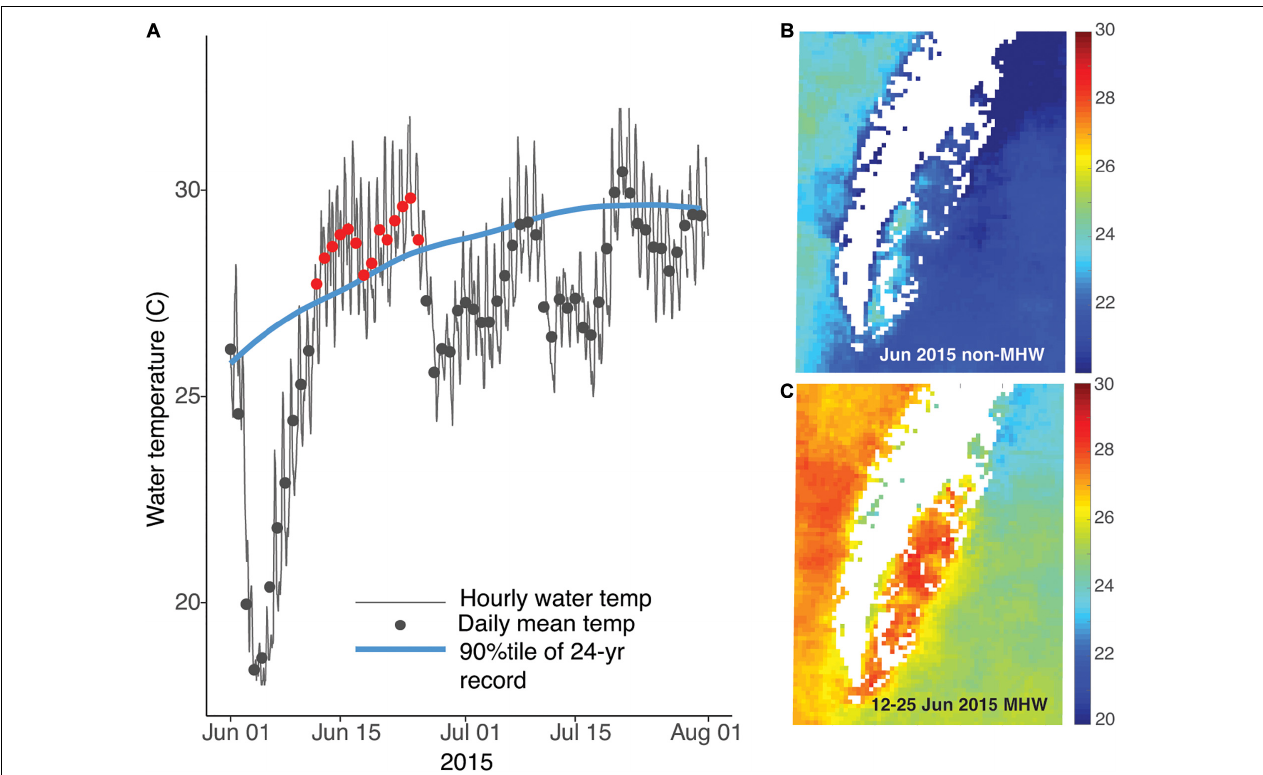
FIGURE 2 | (A) Summer 2015 water temperature at the NOAA tide station in Wachapreague, VA; days that qualified as a MHW are shown in red (12–25 June). The right panels show the sea surface temperature for the Delmarva peninsula during June 2015 across the non-MHW (B) and MHW (C)